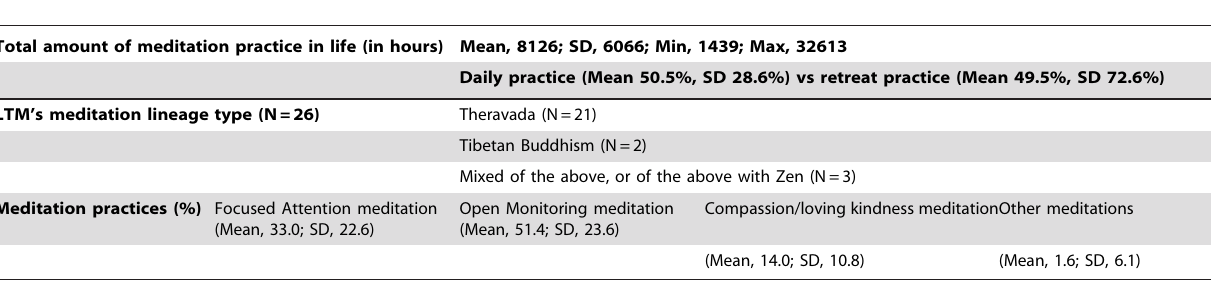
Table 1. Information about long-term meditators’ (LTM) practice history: In our convention, Focused Attention meditation encompasses concentrative practices such as Theravada Jhana, or breath awareness meditation.